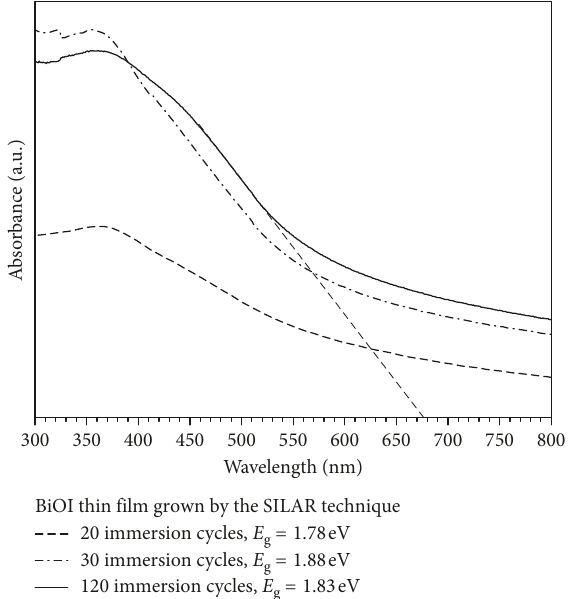
Figure 6: Absorbance spectrum of BiOI thin film grown by SILAR technique.